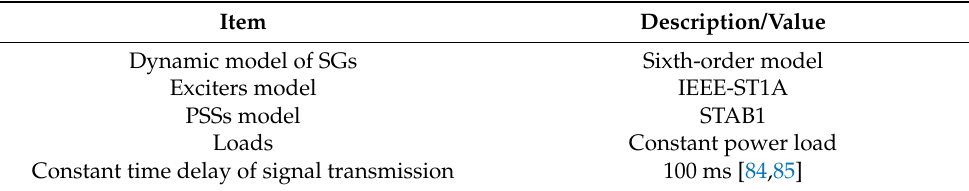
Table 4. Characteristics of the benchmark system.